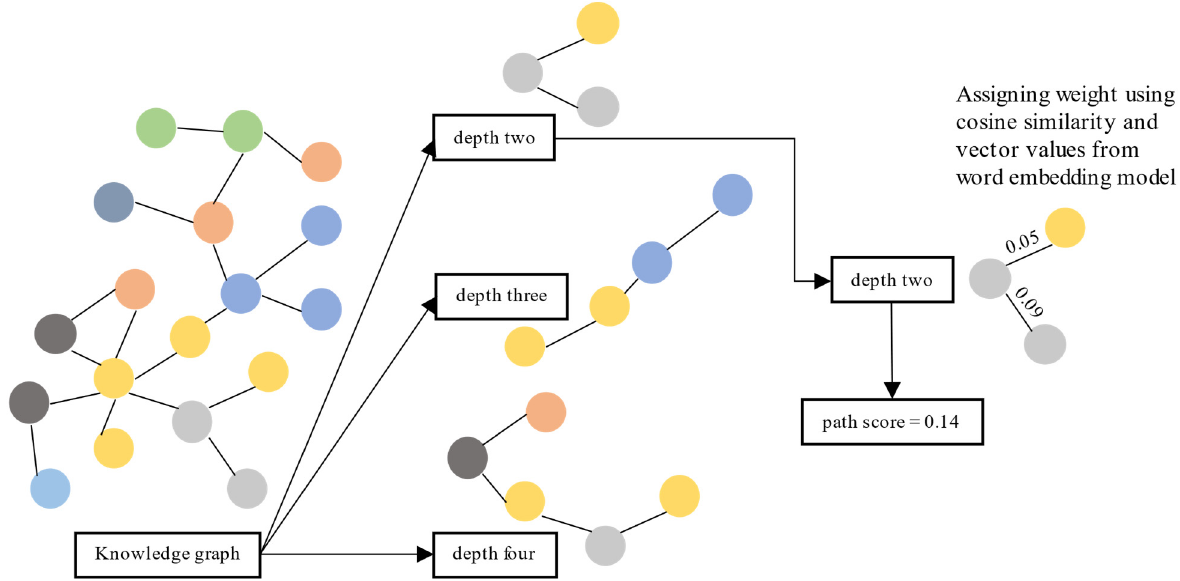
Figure 2. Evaluation process for KG usability using a path ranking framework.